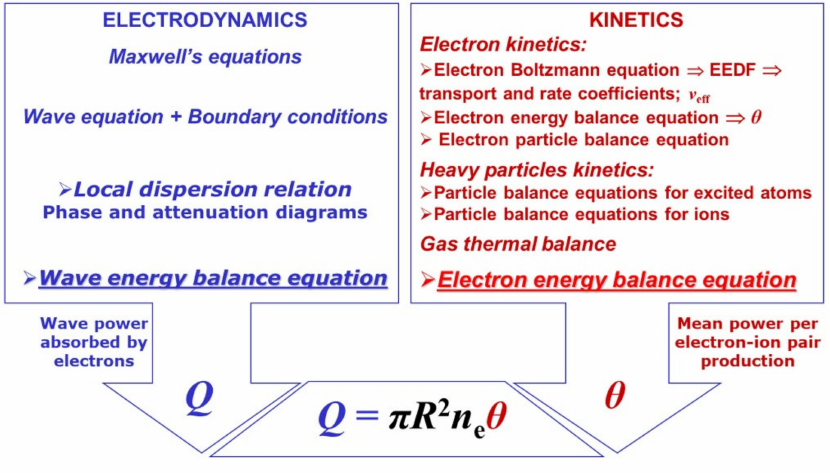
Figure 3. Schematic of self-consistent modeling